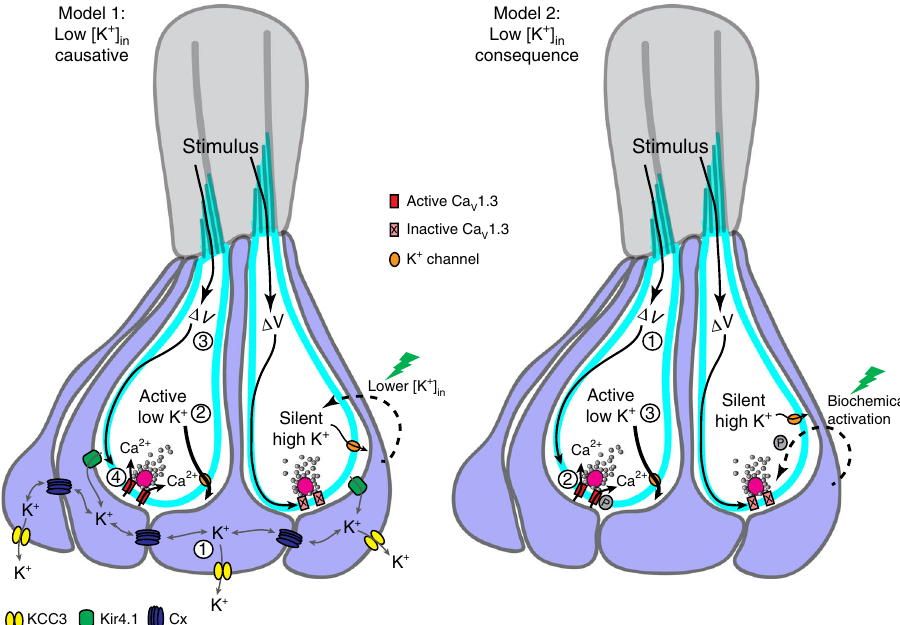
Fig. 8 Model of presynaptic silencing in neuromast organs. Left-side, Model 1: low [K + ] in is causative for Ca V 1.3 channel (red) activation. In active cells, (1) similar to glia, supporting cells may use Kir4.1 channels (green) to take up [K + ] ex , gap junctions (Cx, blue) to spatially buffer K + among syncytia of supporting cells, and a K + -Cl − cotransporter such as KCC3 (yellow) to clear K + from supporting cells. This results in (2) lower [K + ] in in active cells. Cells with lower [K + ] in may be at suf fi ciently depolarized resting membrane potentials where (3) mechanosensation and depolarization ( Δ V) is able to (4) activate Ca V 1.3 channels. In this model, despite K + buffering by supporting cells, not all hair cells are able to be maintained with [K + ] in levels low enough to facilitate presynaptic function. Blocking gap junctions elevates hair-cell [K + ] in and presynaptic function is lost in all cells. After laser damage (green lightning bolt), a signaling cascade could lower [K + ] in levels in silent cells, and raise resting membrane potentials into a range suitable for Ca V 1.3 channel activation. Right-side, Model 2: low [K + ] in is a consequence of presynaptic activity. This schematic demonstrates that (1) mechanosensation and depolarization ( Δ V ), lead to (2) Ca V 1.3 channel activation in active cells. Presynaptic activity results in (3) lower [K + ] in . In this model, Ca V 1.3 channels may be inactive due to a lack of biochemical modi fi cation, such as phosphorylation (P), as shown in this example. Alternatively, Ca V 1.3 channels could also be rendered inactive due to a missing interaction partner or improper assembly at the plasma membrane (these examples not shown). In this example, after laser damage (green lightning bolt), a signaling cascade could promote phosphorylation and lead to Ca V 1.3 channel